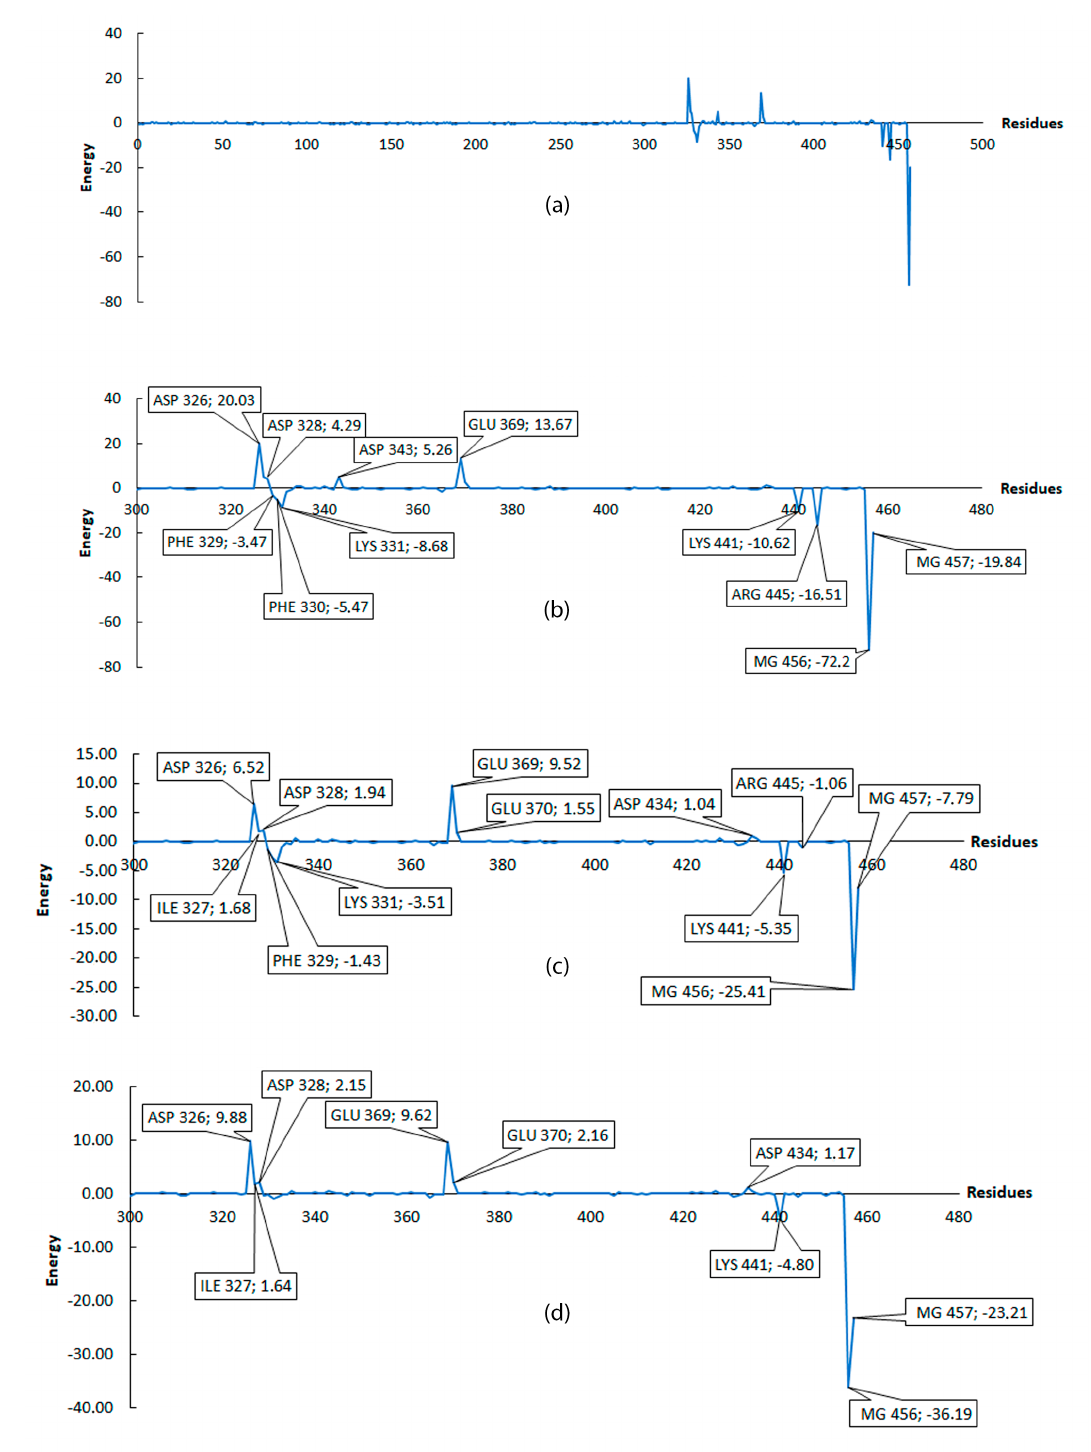
Figure 5. Interaction per residue, from residue 300 to 457. All energies were calculated in kcal/mol. ( a ) Contribution of all residues on MM/PBSA energy for GTP. ( b ) Zoom from residue 300 to 457 for GTP, ( c ) Ligand1, ( d ) Ligand2. Residues with contribution higher than 1 or lower than − 1 are